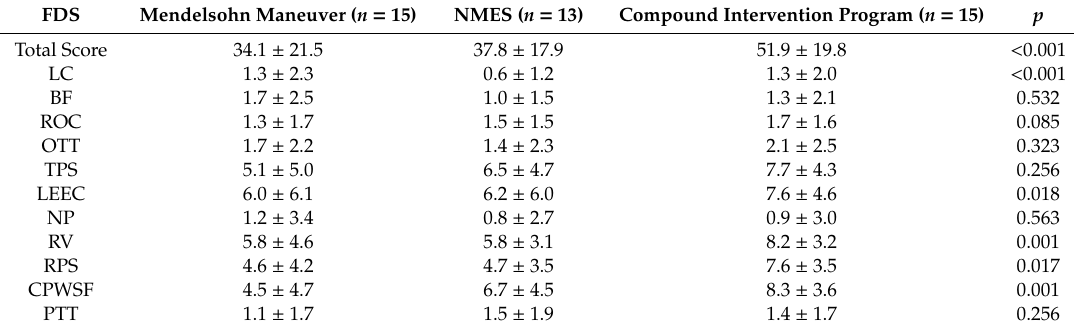
Table 2. FDS characteristics of the Mendelsohn intervention group, the NMES group, and the compound intervention group at the baseline, Mean ± SD.